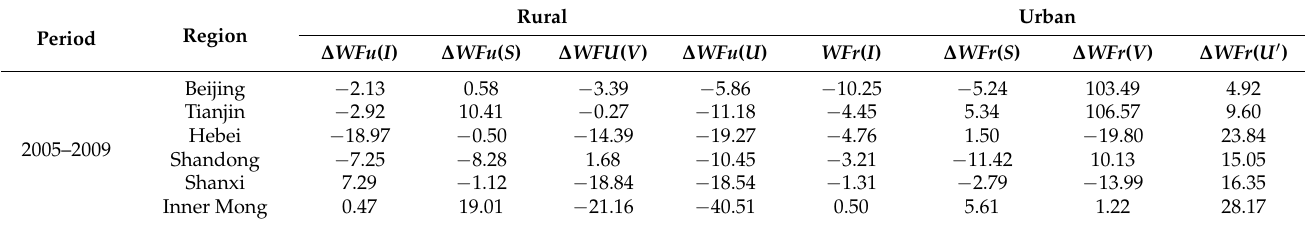
Table A1. Details of decomposition of WF attributable in North China (m 3